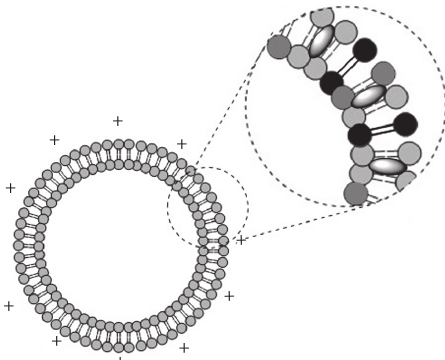
Figure 2: A model of a liposomal membrane containing tetraether lipids PLFE and hGDNT (black), complexing lipids DOTAP (dark grey colored), and helper lipids PC and CH (light grey, in between).